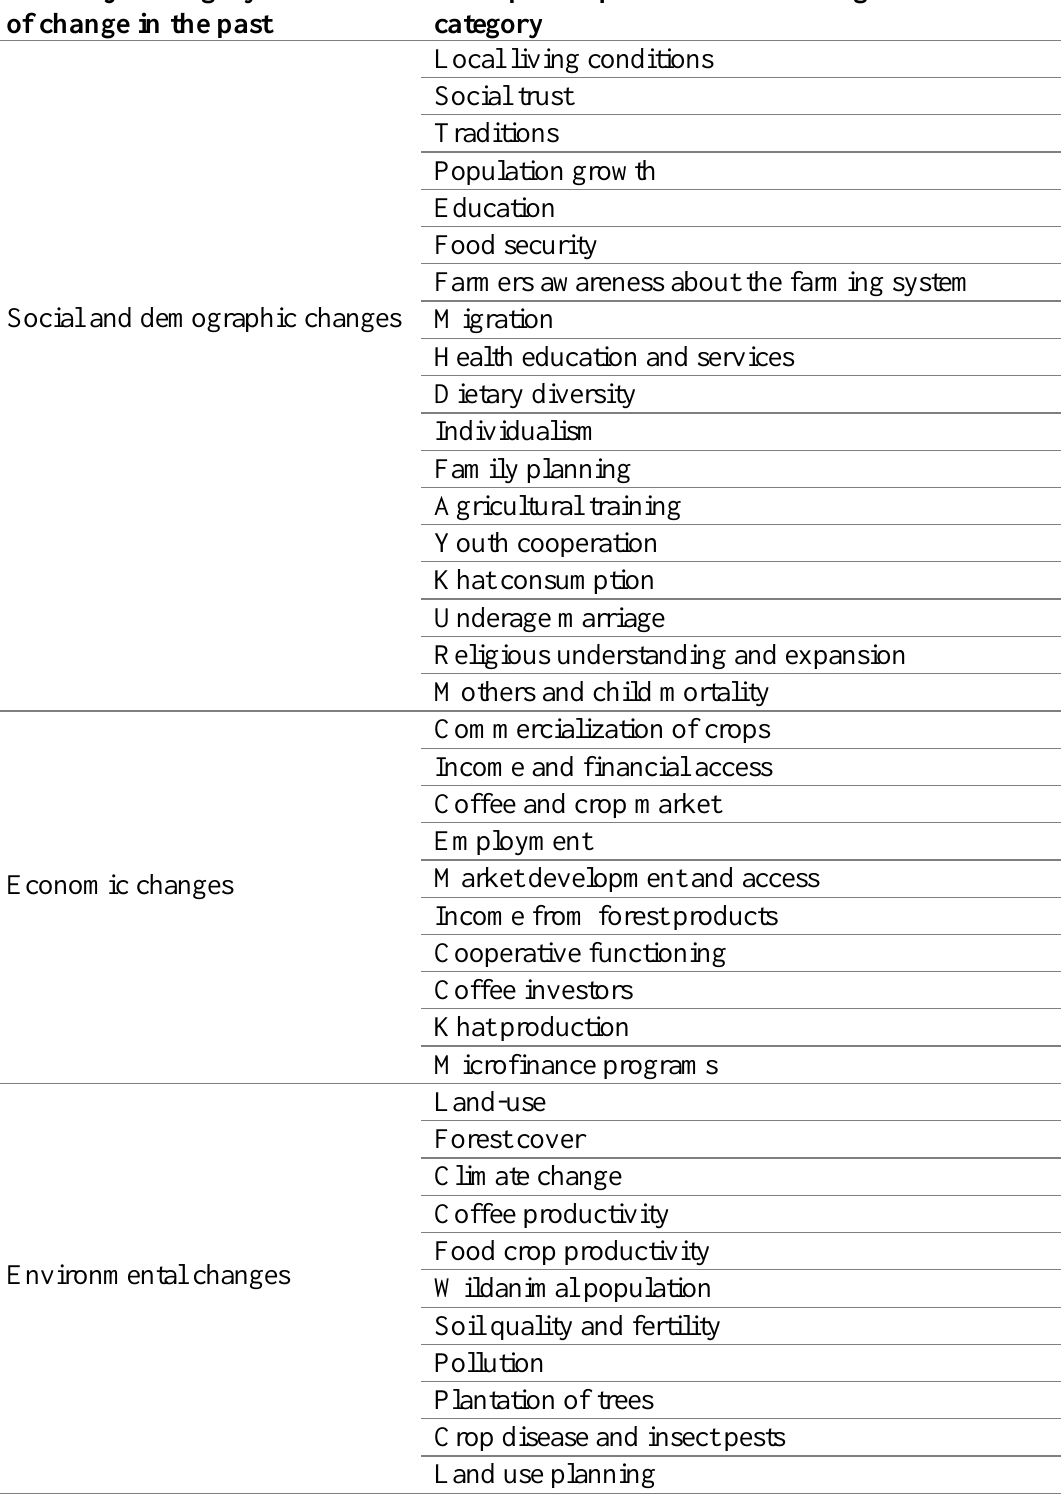
Table A1.4. Main past drivers of change summarized based on their category The major category of